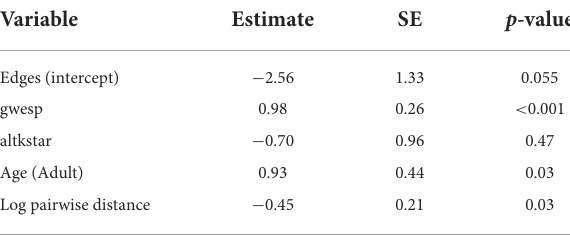
TABLE 1 Main FIV transmission network exponential random graph model results.